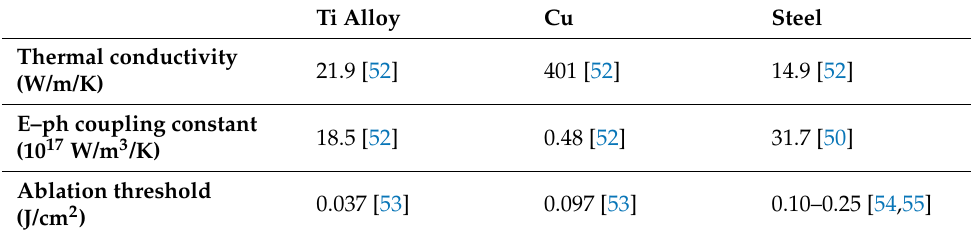
Table 3. Physical properties of textured metals.